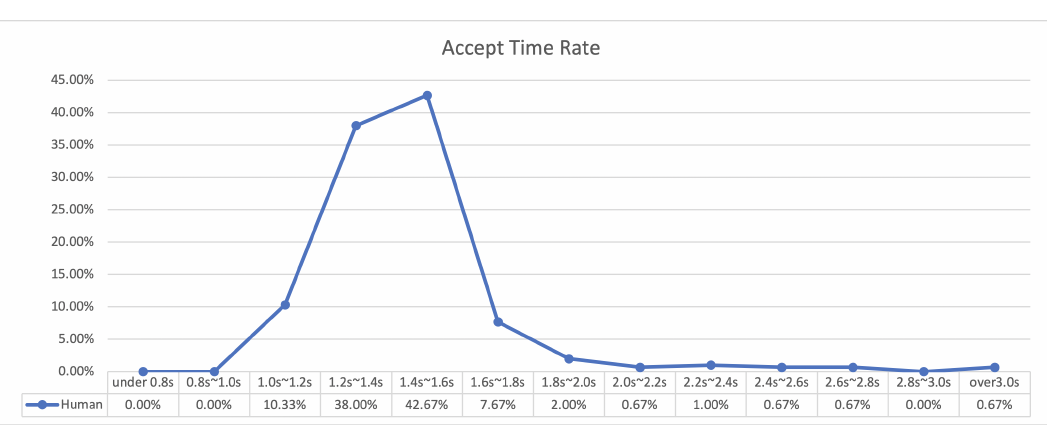
Figure 9. Acceptance counts by human